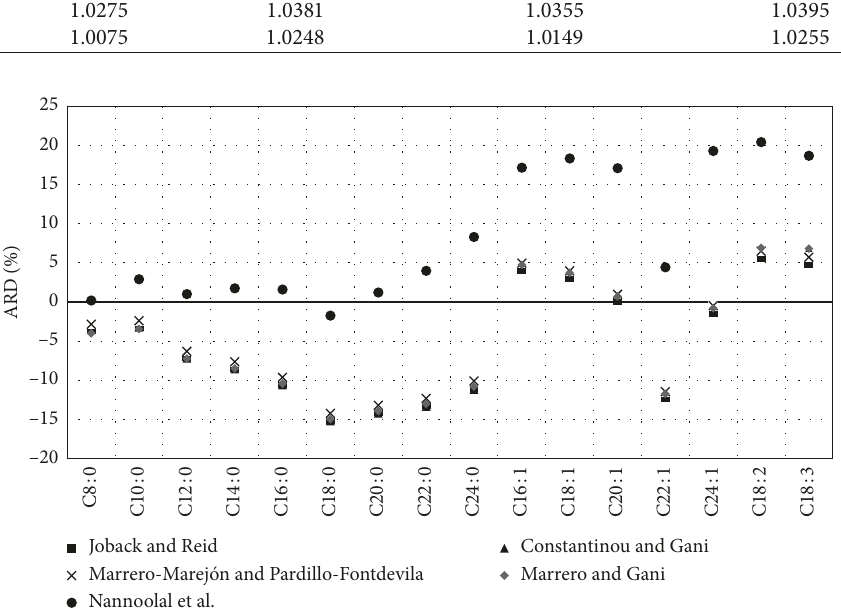
Figure 8: Absolute relative deviations of estimation for the critical